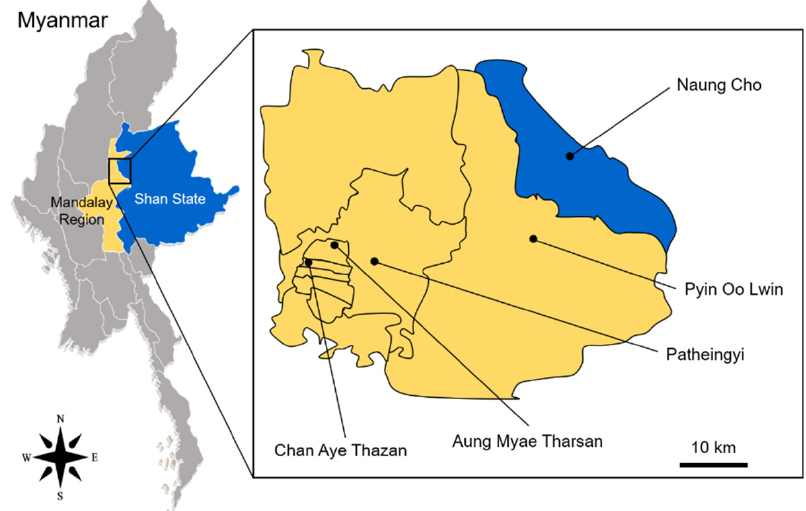
Figure 1. Map of the mosquito collection sites. Aedes aegypti larvae and pupae were collected at 4 townships in Mandalay Region [Patheingyi (21°57 ′ 44.7 ″ N, 96°24 ′ 20.9 ″ E), Pyin Oo Lwin (21°59 ′ 25.9 ″ N, 96°04 ′ 13.0 ″ E), Chan Aye Thazan (21°57 ′ 44.7 ″ N, 96°24 ′ 20.9 ″ E), and Aung Myae Tharsan (21°58 ′ 39.6 ″ N, 96°05 ′ 54.3 ″ E)] and 1 township in Shan State [Naung Cho (22°19 ′ 48.7 ″ N, 96°47 ′ 24.0 ″ E)]. Yellow and blue colors represent Mandalay Region and Shan State, respectively. Closed black circles indicated the collection sites of the mosquito samples.